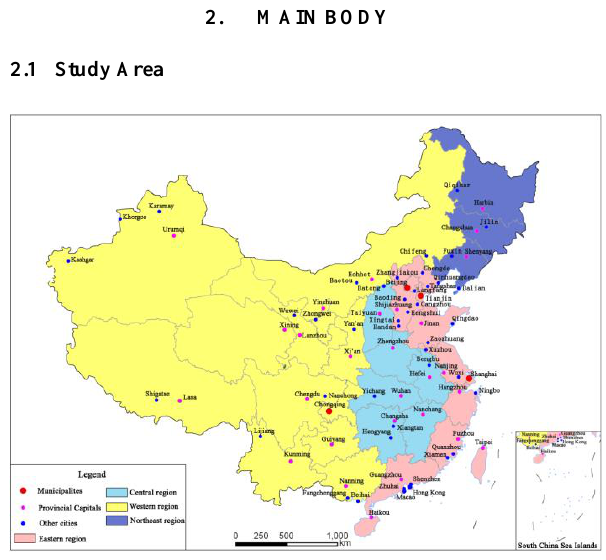
Figure 1 Spatial distribution of 75 sample cities in China Based on city location, administrative level, city population and remotely sensed imagery availability, 75 cities are selected as sample cities in this work, including 4 municipalities,